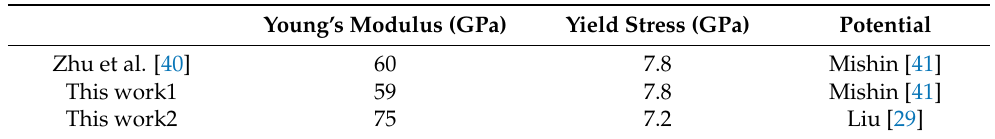
Table 1. Yield stress and Young’s modulus of defect-free pure Al under uniaxial tension. The work 1 is simulated by Mishin potential, while work 2 is the result of Liu